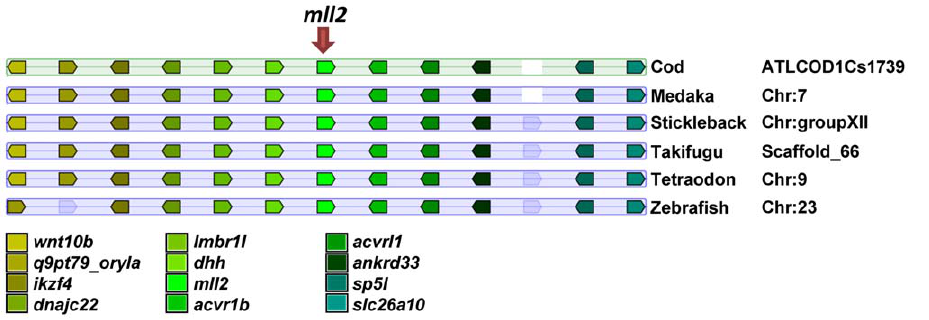
Figure 2. Partial synteny map of the genomic region surrounding mll2 . Synteny was disrupted between teleosts and tetrapods. Orthologous genes in Gadus morhua , Oryzias latipes , Gasterosteus aculeatus , Takifugu rubripes , Tetraodon nigroviridis and Danio rerio are colour coded and represented by block arrows that show their orientation in the genome. Mll2 paralogues are indicated by the arrow. Additional synteny results for other mll paralogues can be found in Figures S1–9. doi:10.1371/journal.pone.0036908.g002 PLoS ONE |